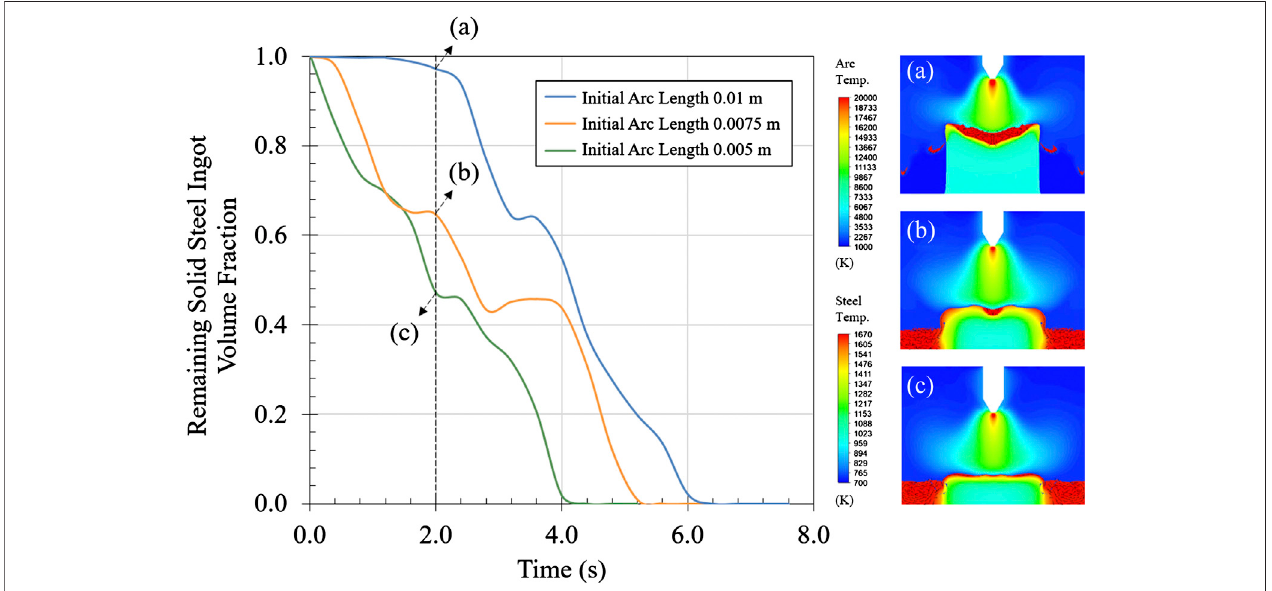
FIGURE 9 | Effect of initial arc length on steel ingot melting ef fi ciency with stationary